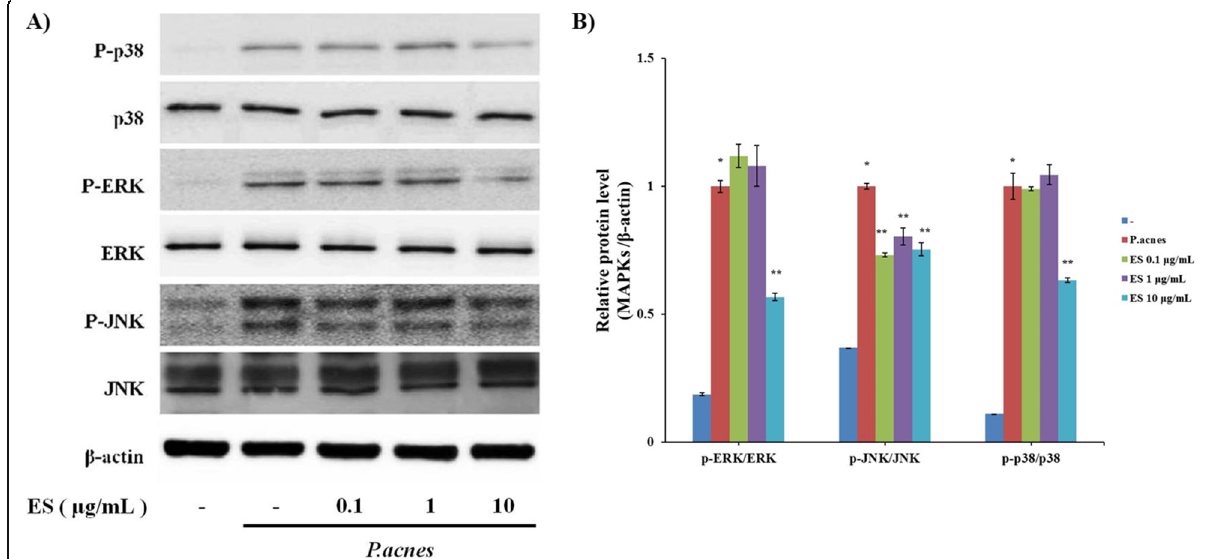
Fig. 4 Effect of ES on the MAPK signaling pathway in P. acnes -indcued THP-1 cells. THP-1 cells were pre-treated with 0.1, 1 and 10 μ g/ml of ES for 1 hrs incubation and then stimulated with P. acnes for 1 hrs incubation. ( a ) Western blot analysis shows that phosphorylation of p38, ERK and JNK is suppressed by ES treatment. ( b ) MAPKs/ β -actin ratio were determined by densitometry. Values represent mean ± S.E.M. Data were